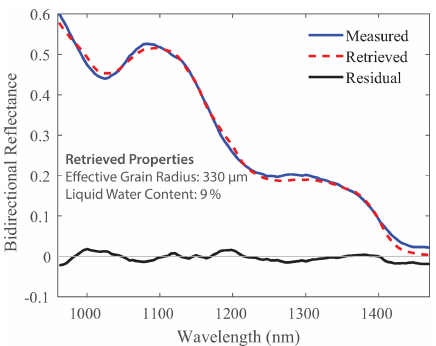
Figure 7. Example of a measured NIR-HSI spectrum, retrieved sim- ulated spectrum using the interstitial sphere model, and the residuals at each